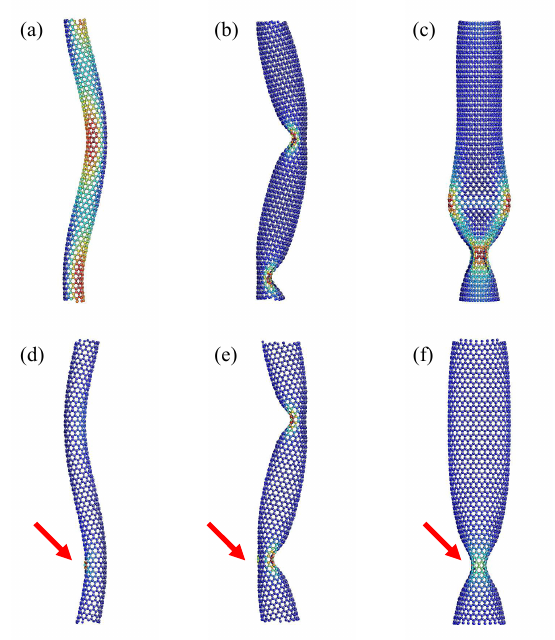
Figure 1. Three buckling modes of zigzag SWNTs with no defect (upper panels) and with a single SW defect (lower): ( a , d ) S-mode, ( b , e ) Z-mode, ( c , f ) I-mode. The red arrows indicate the locations of the SW defect. The chiral indices of SWNTs are: ( a , d ) (12,0), ( b , e ) (18,0), ( c ) (24,0), and ( f )